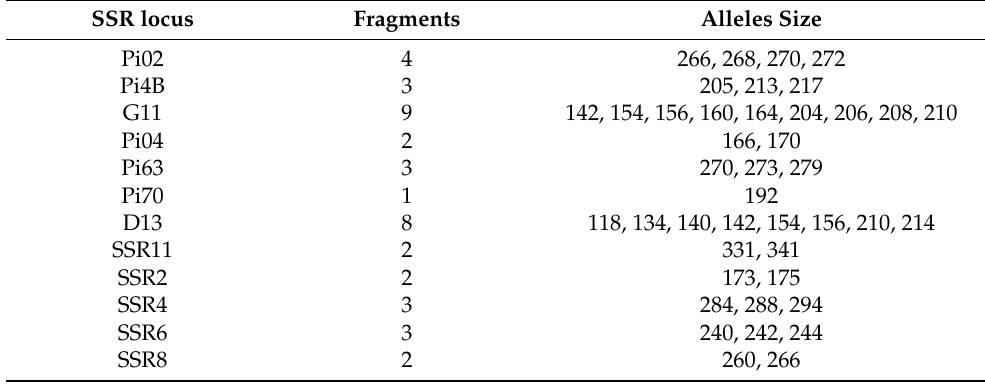
Table 3. Allele sizes identified in the Egyptian population of P . infestans.